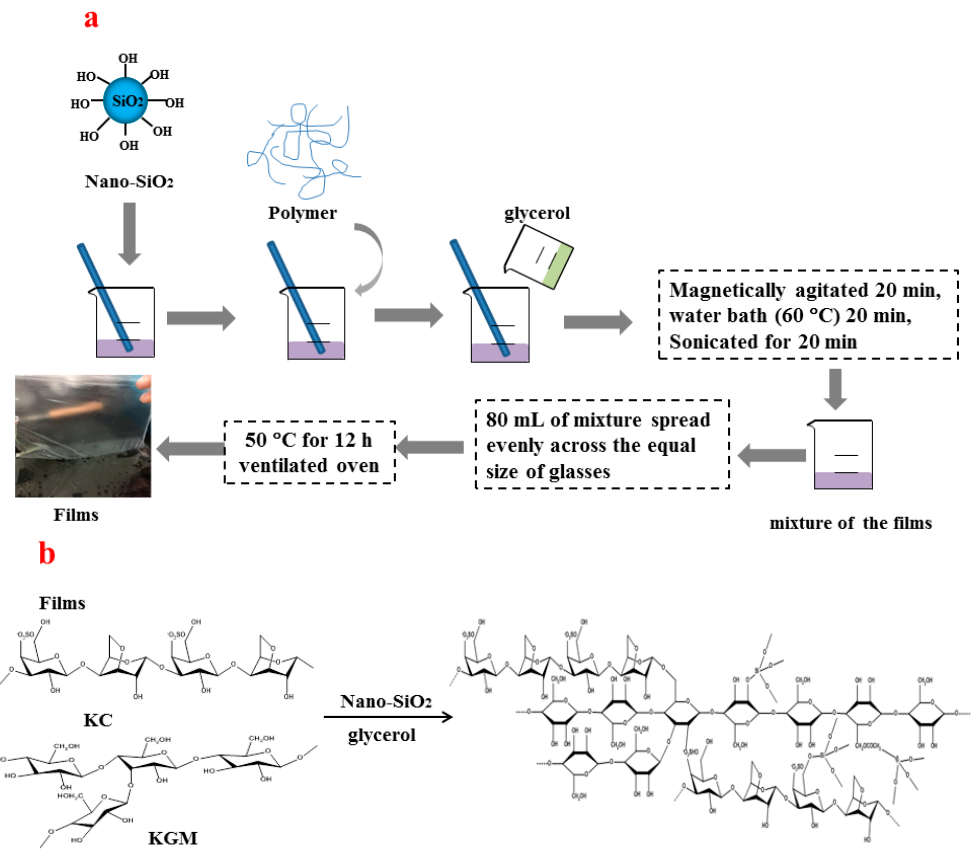
Figure 1. ( a ) Schematic of the films’ preparation, and ( b ) the structure of the obtained